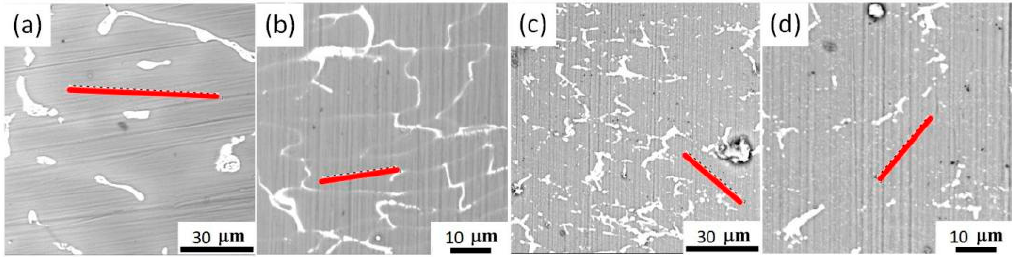
Figure 6. Scanning areas of linescan in α (Al) at different positions of as-cast ACMZ and ACMZ-0.1 nanoparticles, and the red lines are the paths of line scanning. ( a ) The central segregation region of ACMZ; ( b ) The surface of ACMZ; ( c ) The central segregation region of nanoparticles; ( d ) The surface of ACMZ-0.1 nanoparticles.